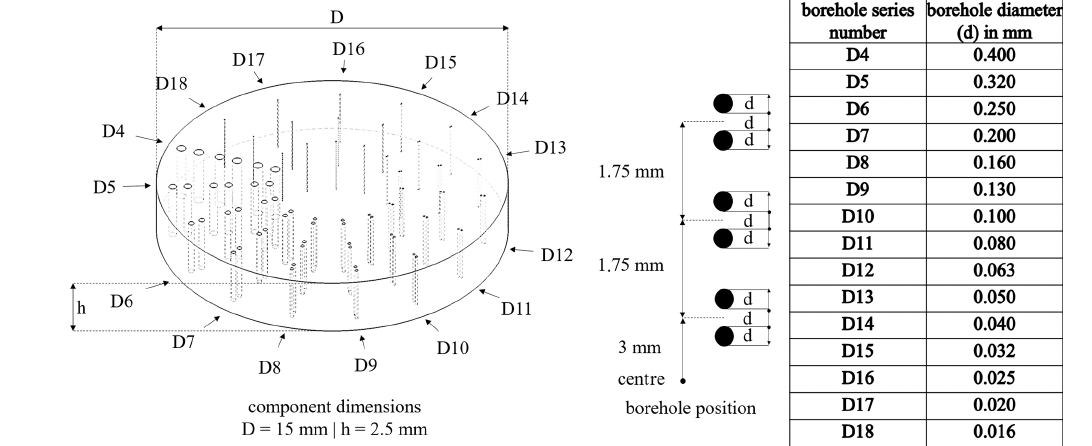
Figure 1. Geometry of the test specimen with borehole diameters of the individual borehole rows D4–D18.